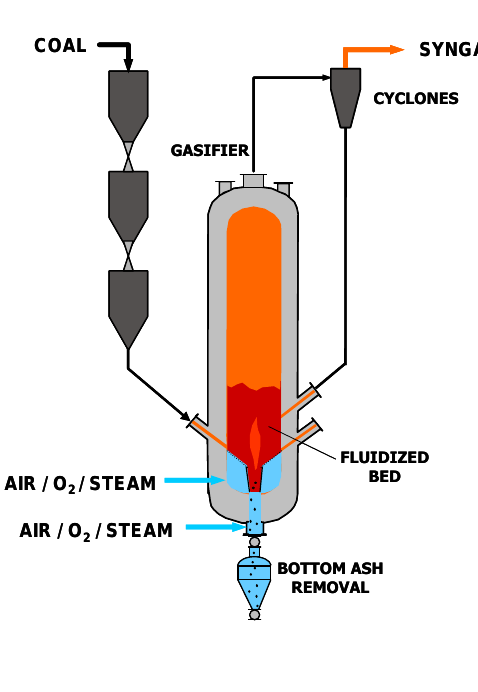
Figure 15. U-Gas Process